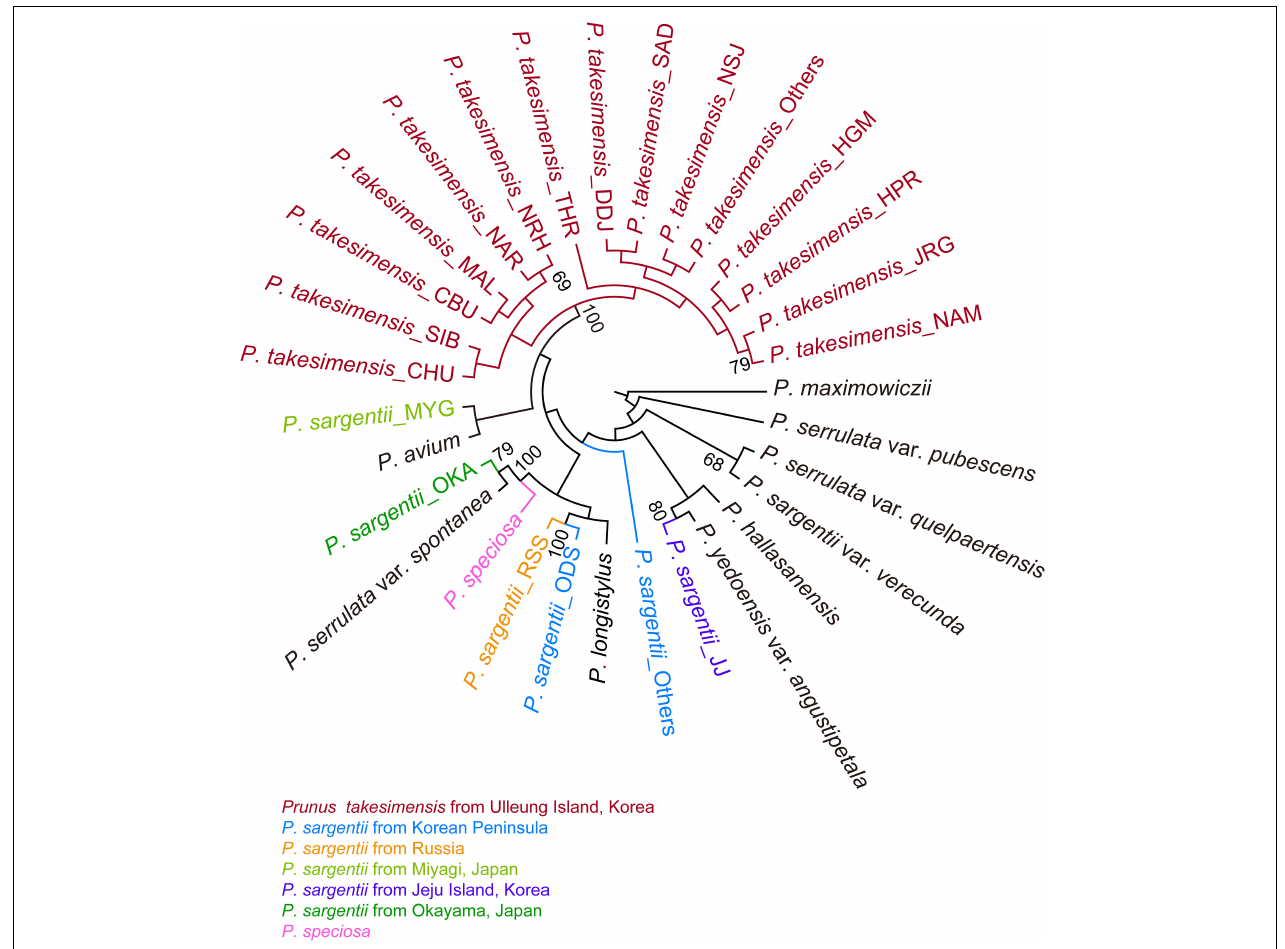
FIGURE 3 | SVDQuartets bootstrap consensus tree produced by PAUP based on MIG-seq dataset including 262 accessions of flowering cherries of the subgenus Cerasus (the genus Prunus ) partitioned for species and populations for P. takesimensis and P. sargentii . Population codes are shown in Table 1 . Color codes for species and geographical regions: red for P. takesimensis from Ulleung Island, blue for P. sargentii from Korean Peninsula, orange for P. sargentii from Russia, light green for P. sargentii from Miyagi, Japan, purple for P. sargentii from Jeju Island, South Korea, dark green for P. sargentii from Okayama, Japan, and pink for P. speciosa . Numbers above major branches indicate bootstrap support (BS)